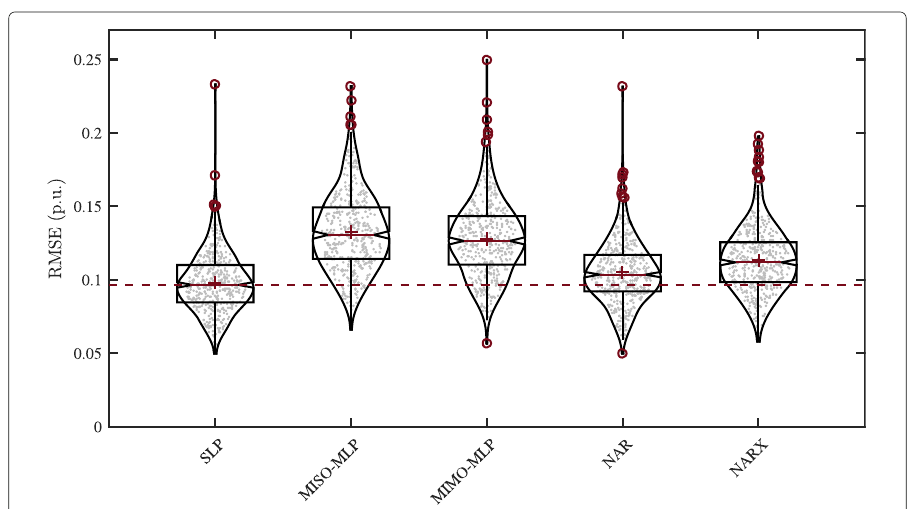
Fig. 6 RMSE (p.u.) predicting a sample of 444 single homes day by day between September and December. Median error (red horizontal line), mean error (red cross), 95% confidence interval (notch), IQR and outliers (red circles) are denoted with box-plots. Estimated distribution is represented using violin plots (Hintze and Nelson 1998). While the error is approximately normally distributed among the households, no network architecture was significantly more accurate on average than the SLP forecast (red dashed line)